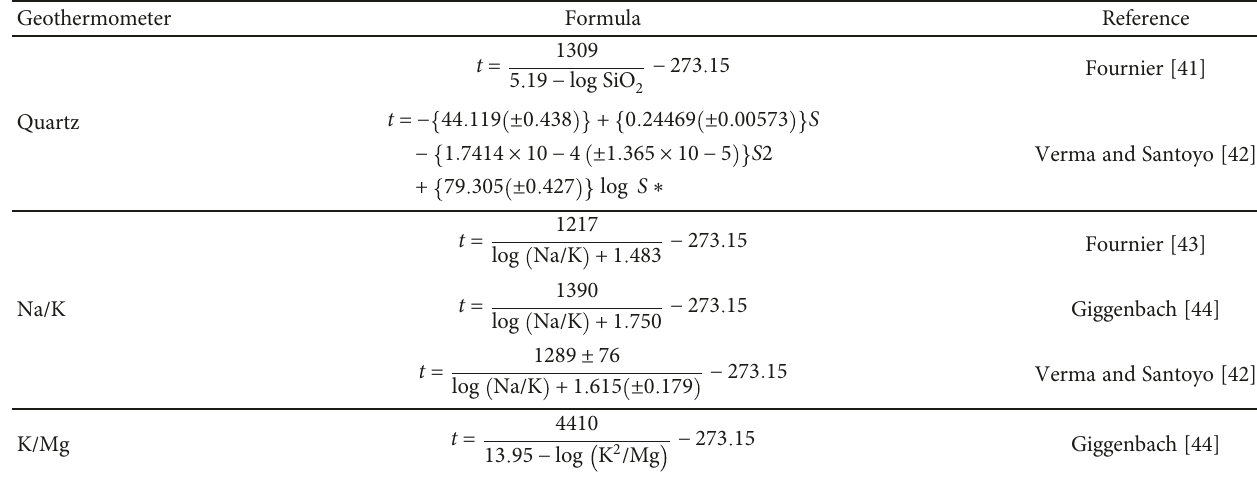
Table 3: Formulas of chemical geothermometers used in this